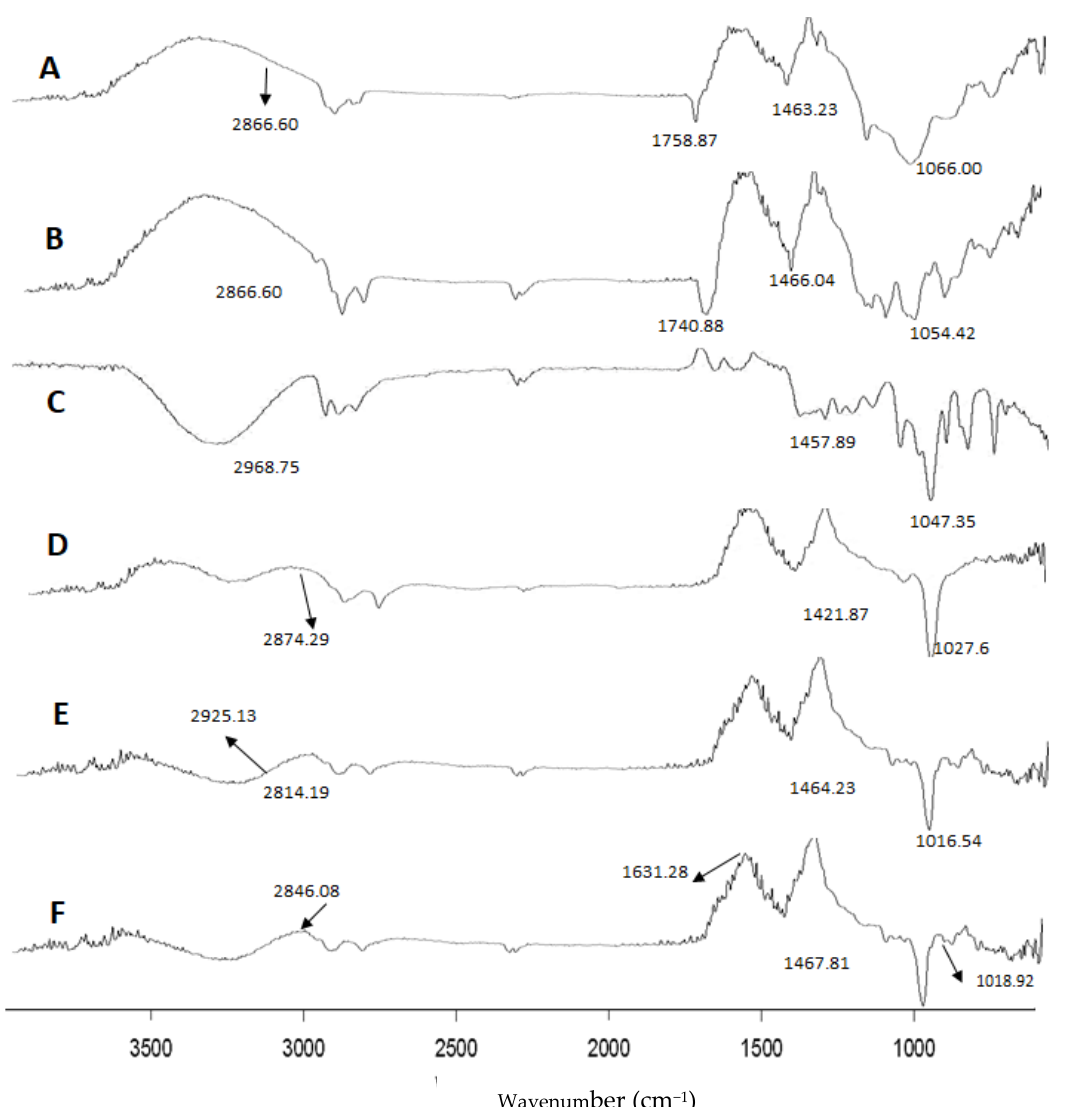
Figure 3. FTIR spectra of TA ( A ), PC ( B ), PEG ( C ), Ethanol ( D ), TACG ( E ), and TAEG (TA-5) ( F ).